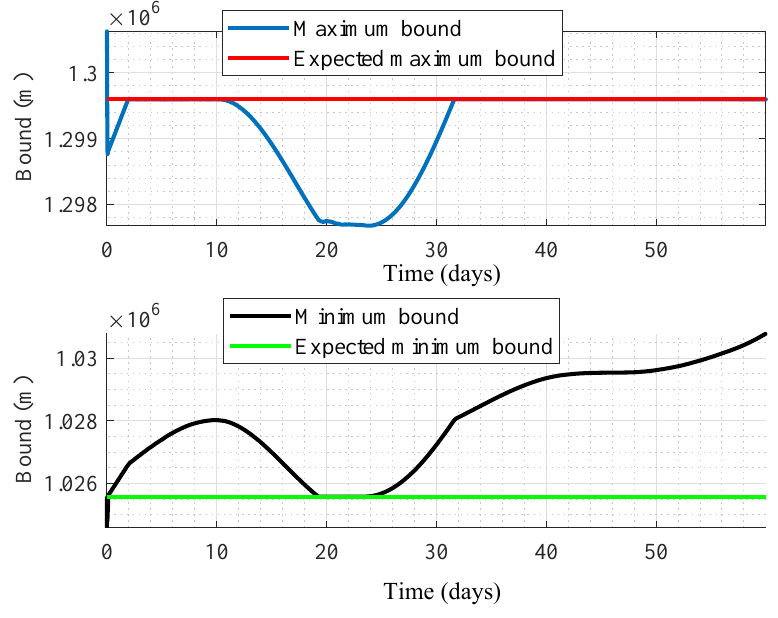
Figure 7. Relative motion-bound changing with